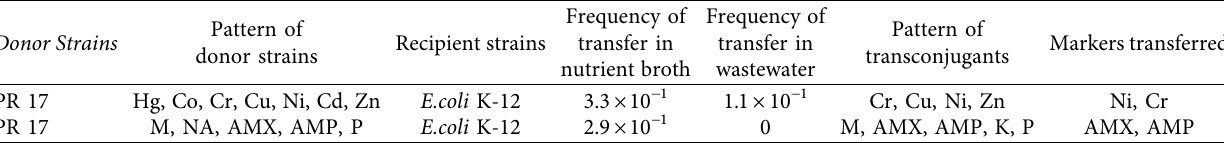
Table 9: Incidence of resistance transfer among the antibiotic/heavy metal-resistant P. vulgaris isolates to E. coli K-12 from hospital wastewater.